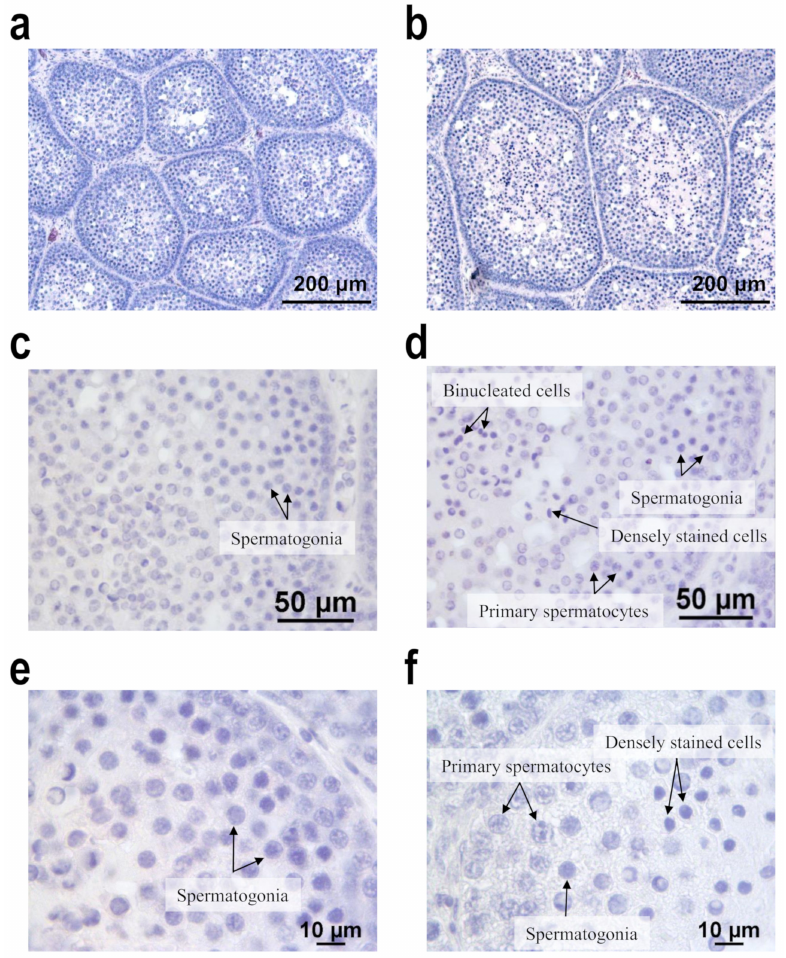
Figure 1. Effects of the nocturnal 1-h lighting on the histological characteristics of testes of our mule ducks. ( a ) Section from the testis of a mule duck in Group C displays thin seminiferous tubules. ( b ) Section from Group L+ reveals thick seminiferous tubules. ( c , e ) Section from Group C does not exhibit spermatogenesis, and only spermatogonia exist. ( d , f ) Section from Group L+ displays active spermatogenesis, and primary spermatocytes, as well as spermatogonia, are present. In addition, some small deeply stained cells and binucleated cells are present in the central area of the tubule in sections from Group B. No spermatozoa are observed in any sections. Group C was subjected to the natural photoperiod, and Group L+ was supplemented with 1-h artificial light from 20:00 to 21:00, in addition to the natural photoperiod. Hematoxylin and eosin